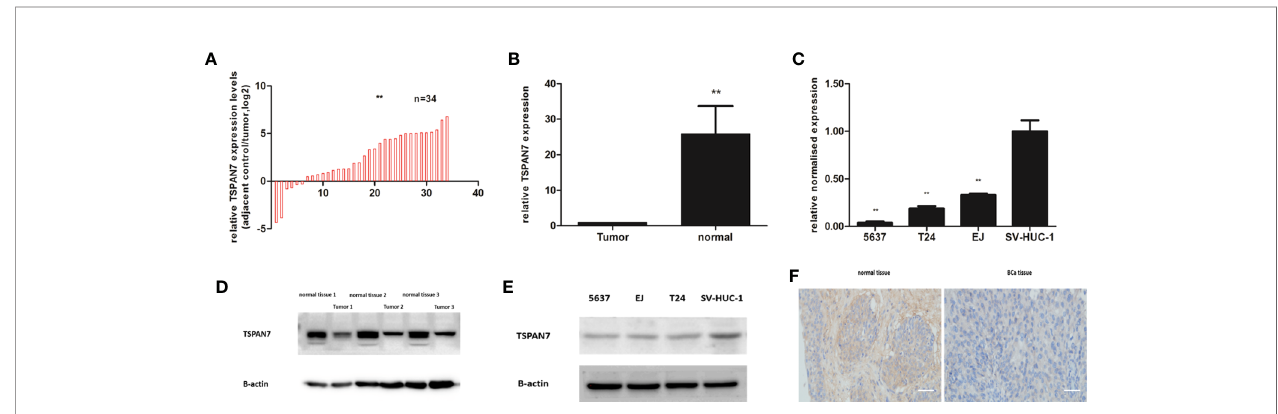
FIGURE 2 | TSPAN7 was downregulation in BCa patients and cell lines. (A, B) TSPAN7 mRNA expression in BCa tissue samples was lower than in normal tissue. (C) TSPAN7 mRNA was signi fi cantly downregulation in BCa cell lines (T24, 5637, EJ) compared with the normal bladder epithelial cell line (SV-HUC-1). (D) In Western blot, TSPAN7 showed a higher expression in normal tissue. (E) In Western blot, TSPAN7 showed a higher expression in normal bladder epithelial cell line. (F) Immunohistochemistry (IHC) showed the protein level of TSPAN7 was increased in normal bladder tissue. Scale bars, 100 m m. **p<0.01.